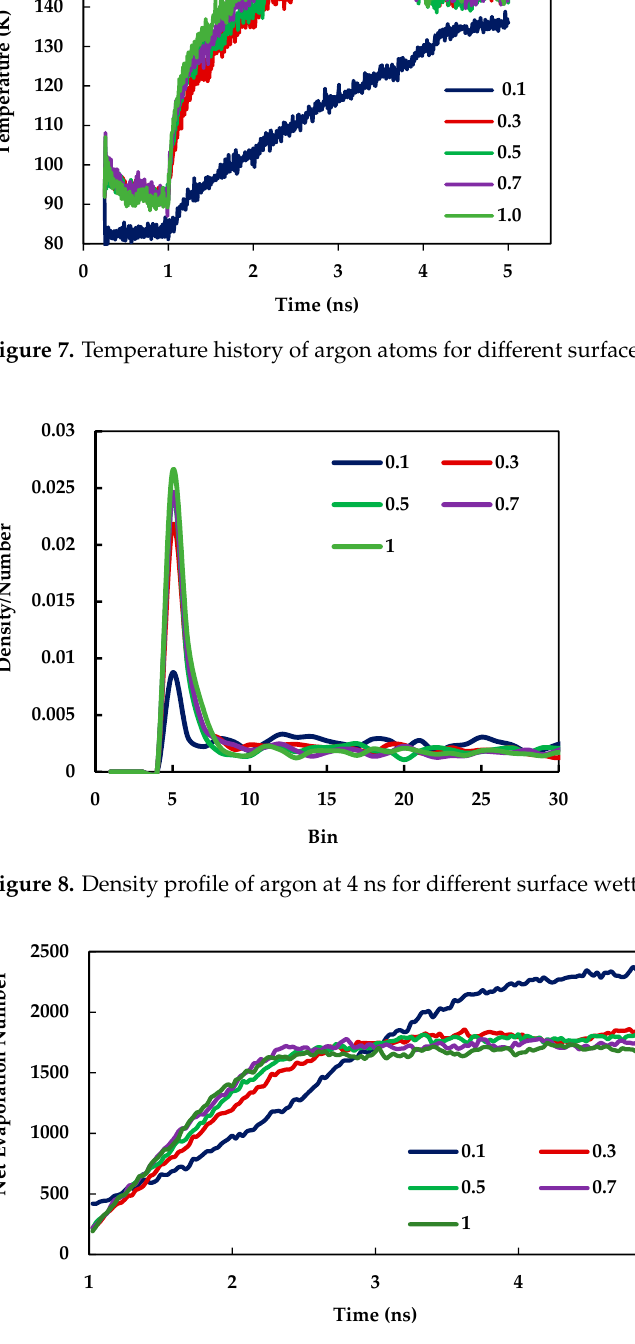
Figure 9. Net evaporation number for different surface wettability as a function of time.